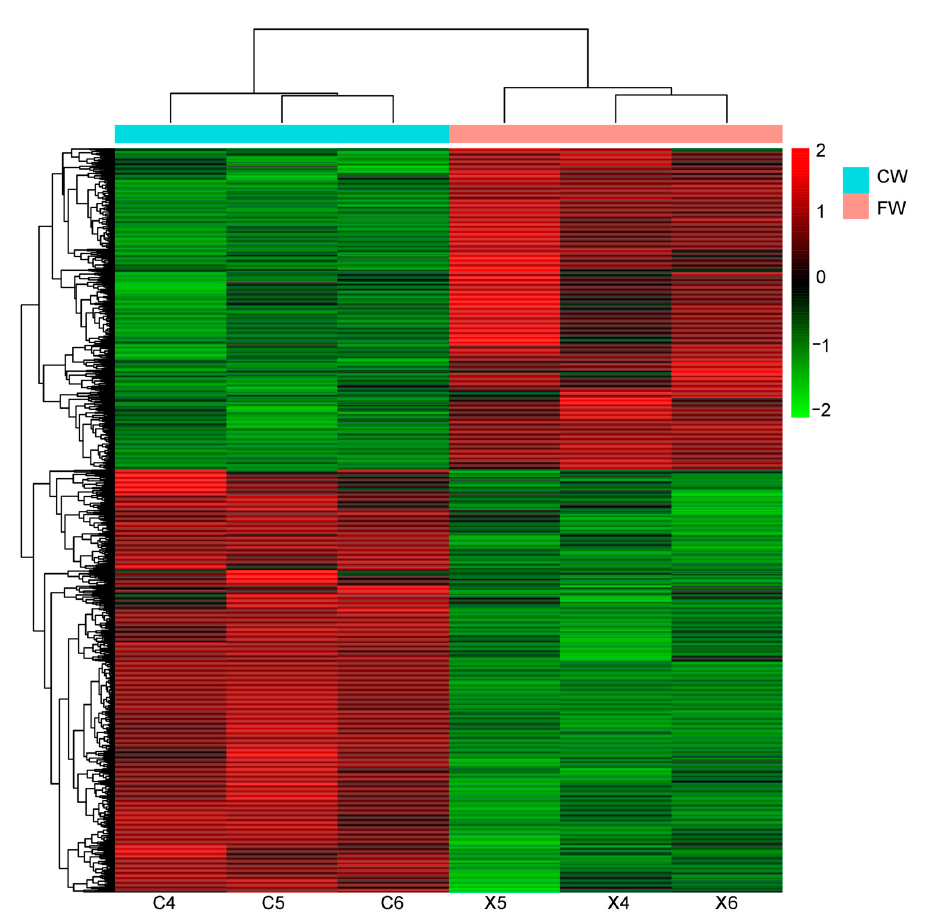
Figure 2. Heatmap analysis of the DEGs in hair follicles between coarse and fine wool from rabbits. Increased expression is marked in red, and decreased expression is marked in green; C represents coarse wool group; X represents fine wool group. Table 1. Expression levels of differentially expressed KRT and KAP genes between coarse and fine wool of Angora rabbits.